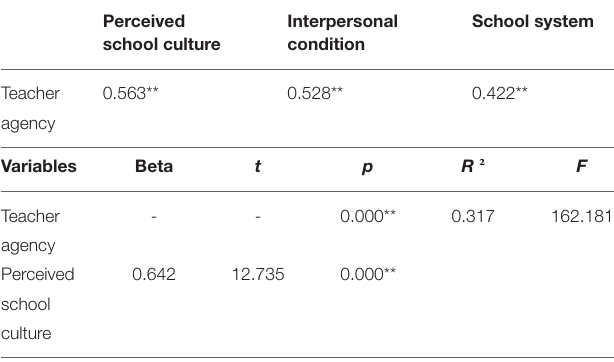
TABLE 4 | Correlations and correlation of the